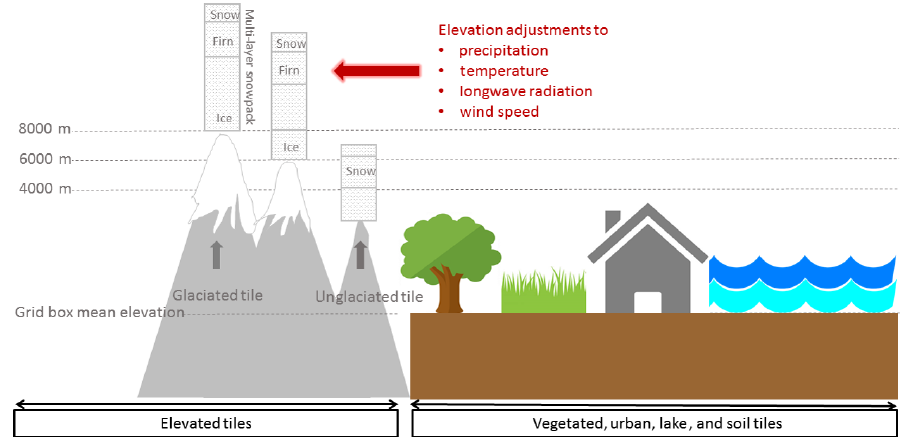
Figure 1. Schematic of JULES surface types inside a single grid box. The new elevated glaciated and unglaciated tiles are shown on the left-hand side. Note that elevated glaciated and unglaciated tiles are not allowed to share a grid box with the other